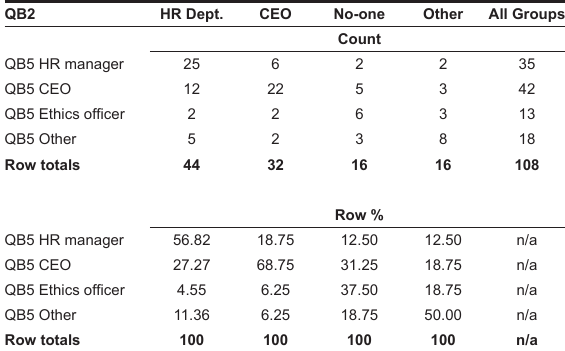
TABLE 9 Summary frequency table QB2(4) × QB5(4): who is responsible versus who should be responsible for ethics in the organisation